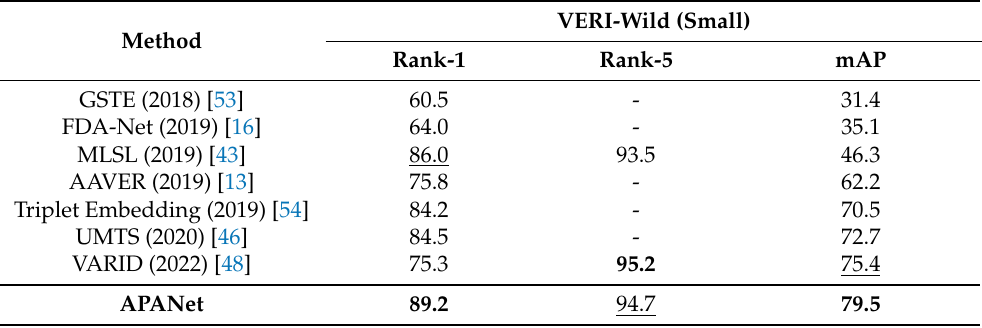
Table 8. Comparison results with state-of-the-art methods on VERI-Wild [16] in terms of rank and mAP. ‘-’ indicates the result is not reported. Note that the best performance is marked in bold and the second best accuracy is